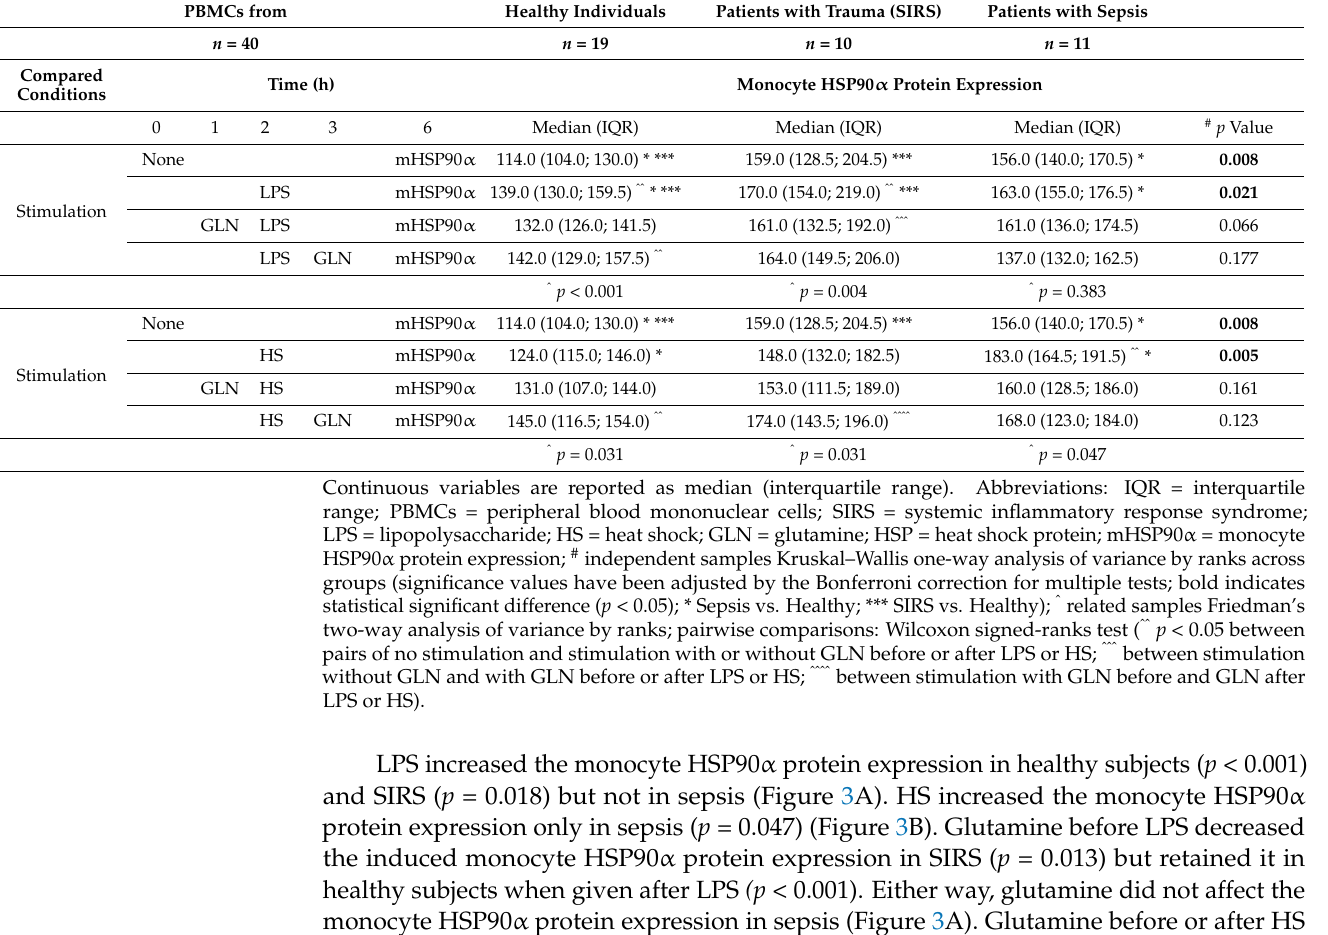
Table 3. Comparison analysis of monocyte HSP90 α protein expression among different stimulation conditions with or without glutamine pre- or post-treatment in patients with sepsis or trauma and healthy subjects. Patients with Trauma (SIRS) Patients with